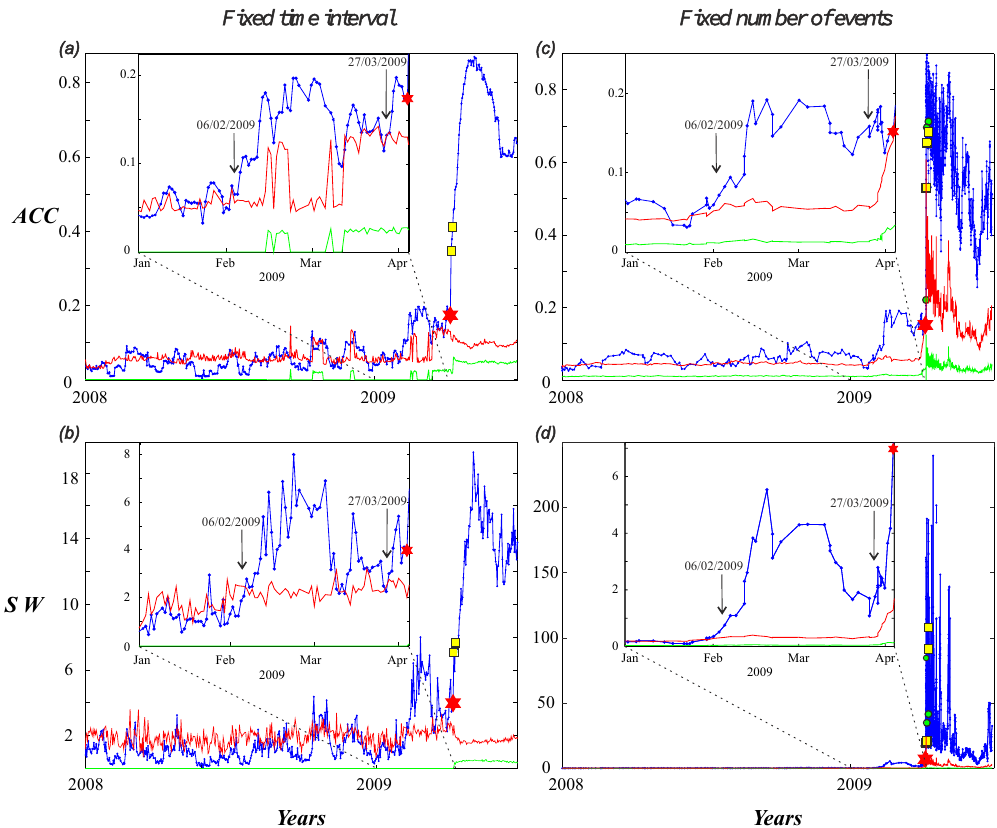
Figure 3. ACC and SW indices global statistical network measures from 1 January 2008 to 30 June 2009. Computations were performed in the space window centered at the mainshock epicenter (42.42 ◦ N, 13.39 ◦ E), with radius R 1 = 1 ◦ . The left column depicts the results obtained with a constant time shift of 1 day. The right column depicts the results obtained with a constant number of event shifts. Earthquakes in the magnitude ranges of 4 . 3 ≤ M ≤ 4 . 9 and 5 . 0 ≤ M ≤ 5 . 6 are marked with green circles and yellow squares, respectively. The mainshock that occurred on 6 April 2009 is marked with a red star. Red and green lines represent statistically significant levels of 95 and 5%, respectively (see the description in the methods section). The inset shows a zoom in the period 1 January to 6 April 2009. The arrow in the inset marks the onset of the statistically significant changes from the random network